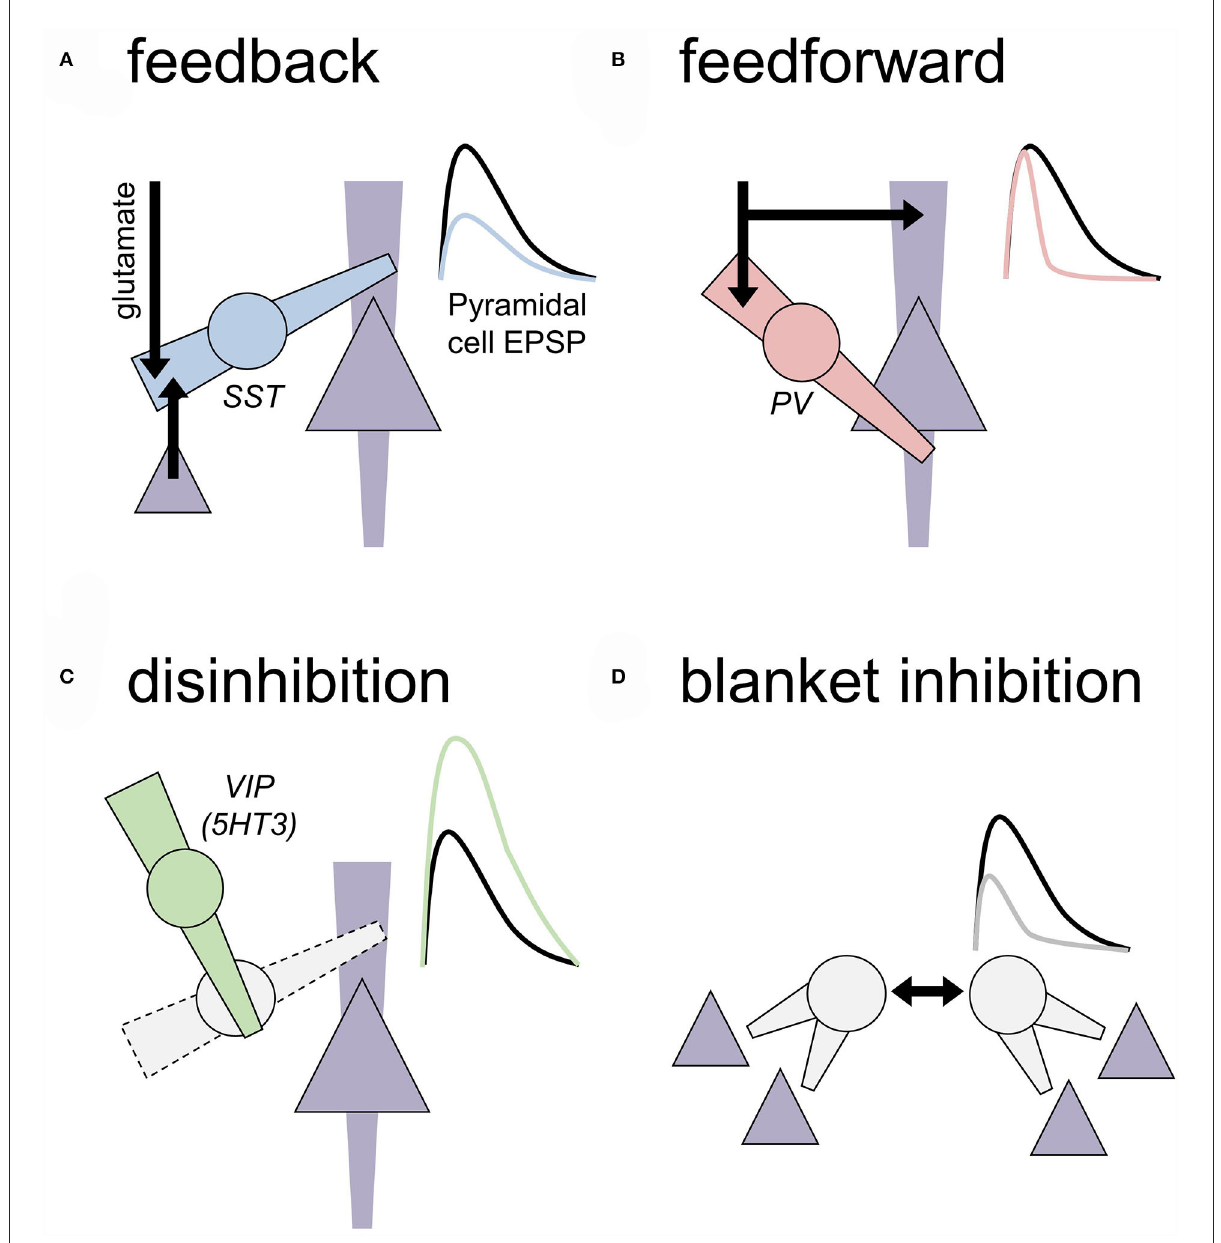
FIGURE1 Motifs of local inhibition in the central nervous system. Generalized motifs of cortical inhibition are depicted that include cellular/subcellular targets and approximated effects on an excitatory postsynaptic potential (EPSP) recorded from a nearby pyramidal cell. To some extent, these inhibitory transmission motifs are present across all cortical layers, but some motifs are more prevalent in some layers based on where IN subtypes reside. (A) Feedback inhibition. A local inhibitory neuron (IN; circle) receives an excitatory transmission from long-range glutamate inputs or local competing ensembles or cortical columns (black arrows). Feedback INs regulate dendritic compartments of principal neurons (triangle) to decrease the amplitude of EPSPs. Cortical somatostatin (SST) INs represent a primary example of feedback INs. (B) Feedforward inhibition. A local IN and neighboring principal neuron receive coincidental excitatory input. Feedforward INs, often expressing parvalbumin (PV), are optimized to inhibit the nearby cell bodies rapidly and faithfully after receiving excitatory inputs. Through this process, feedforward INs restrict the window during which EPSPs may be converted into action potential firing. Feedforward INs can regulate dozens of related principal cells to recruit neuronal ensembles and generate oscillatory activity in many brain areas. (C) Disinhibition. INs can inhibit other INs to relieve inhibition and ultimately facilitate EPSPs on the principal neurons. Prime examples of this motif include SST-INs inhibiting PV-INs and vasoactive intestinal peptide (VIP) INs inhibiting SST-INs. (D) Blanket inhibition. Some INs subtypes help drive their activity to maintain wide networks of inhibition and low levels of excitatory drive throughout broad brain areas. For example, PV-INs form extensive gap junctions with other PV-INs and cholecystokinin INs can co-release glutamate to excite onto each